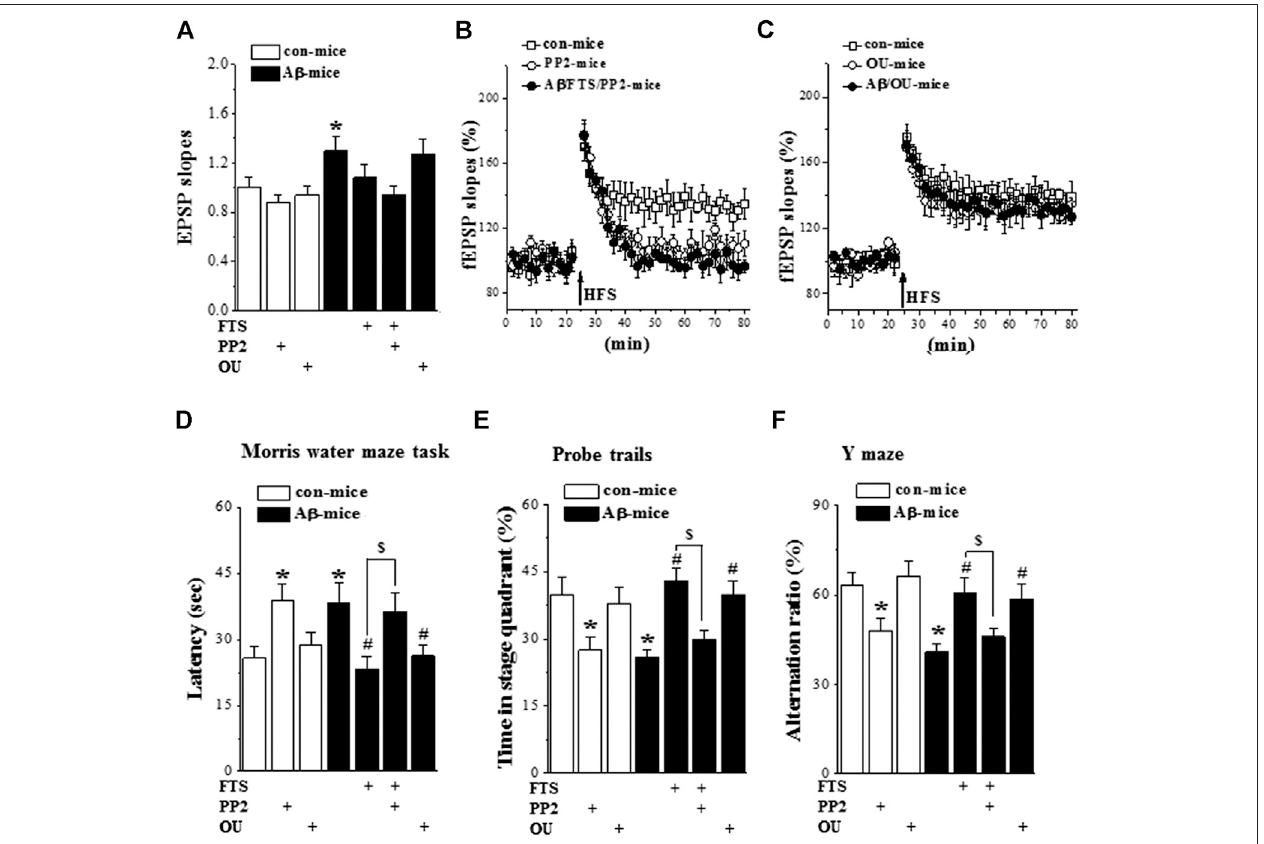
FIGURE 7 | A β 1-42 -activated Ras impairs LTP and spatial cognition through down-regulation of Src. (A) – (C) . Input/output curve and LTP induction in control mice and A β 1-42 /FTS-mice treated with PP2 or ouabain. (n (cid:1) 8 per group). (D) – (F) . Bar graphs represent the mean latency (sec) to reach the hidden-platform in MWM, the percentage of time spent in target quadrant in probe trails, and mean of alternation rate (%) in Y-maze task. * p < 0.05 vs. control mice; # p < 0.05 vs. A β 1-42